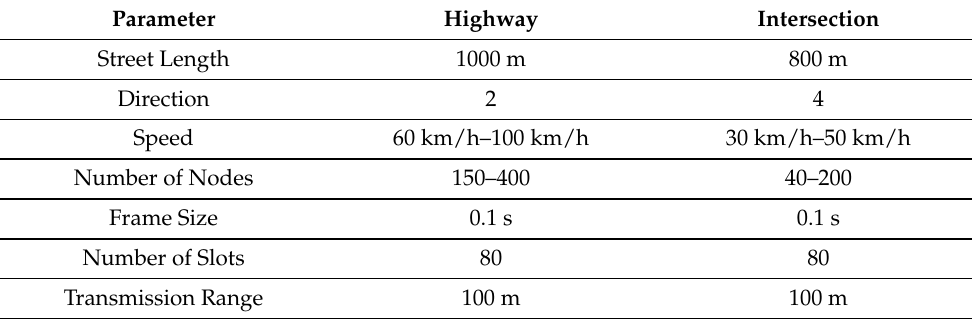
Table 1. Simulation